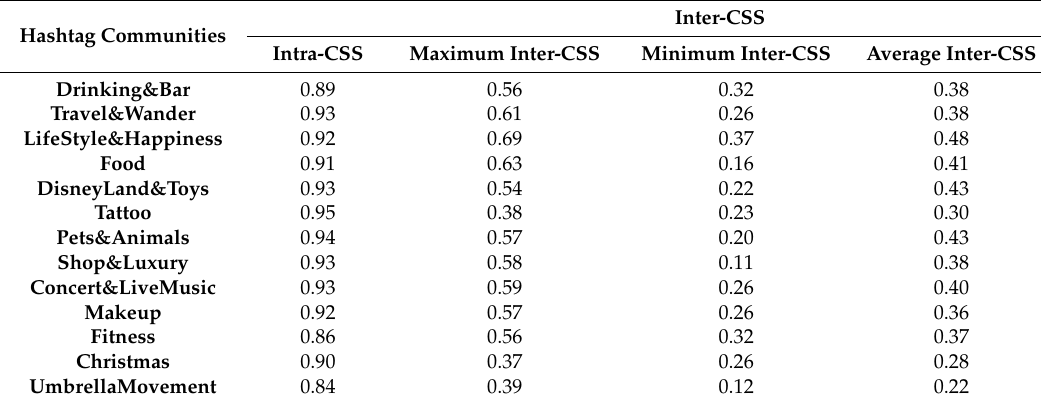
Table 4. A comparison of the semantic similarities between